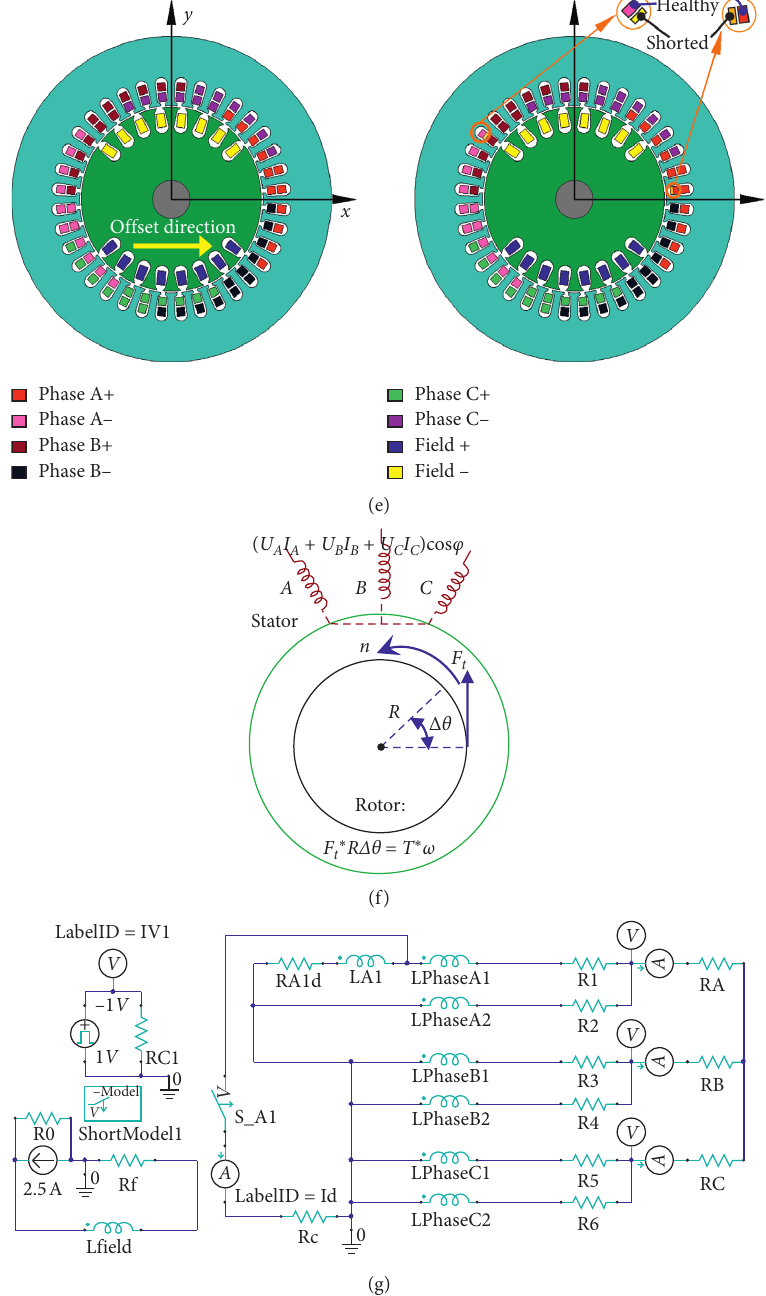
Figure 5: CS-5 prototype generator: (a) picture of the generator set, (b) high-precision gauges, (c) picture of short circuit taps, (d) short circuit tap set, (e) physical 2D model, (f) electromagnetic torque energy conversion model, and (g) coupling circuit